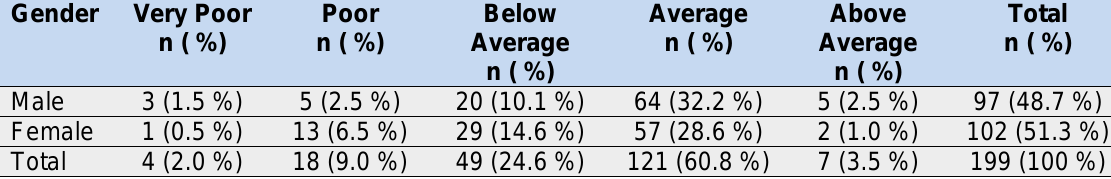
Table 2: Number and percentage of child’s intellectual ability (IQ) of children (n=199) Gender